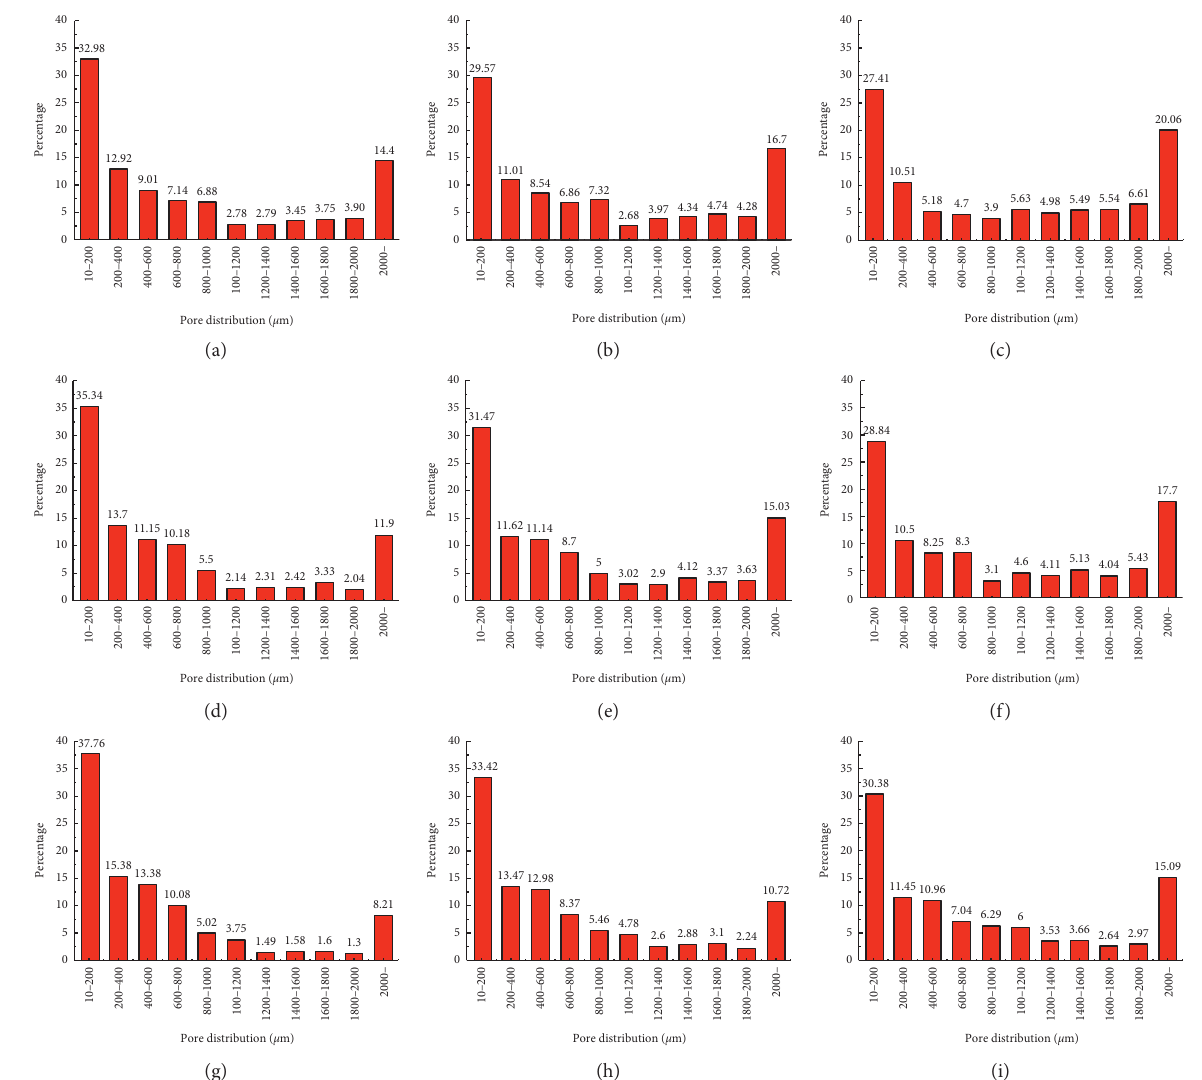
Figure 26: Pore size distribution of DSC with different DSRRs. (a) Room temperature, DSRR-0%. (b) 300 ° C, DSRR-0%. (c) 500 ° C, DSRR- 0%. (d) Room temperature, DSRR-60%, (e) 300 ° C, DSRR-60%. (f) 500 ° C, DSRR-60%. (g) room temperature, DSRR-100%. (h) 300 ° C, DSRR- 100%. (i) 500 ° C,